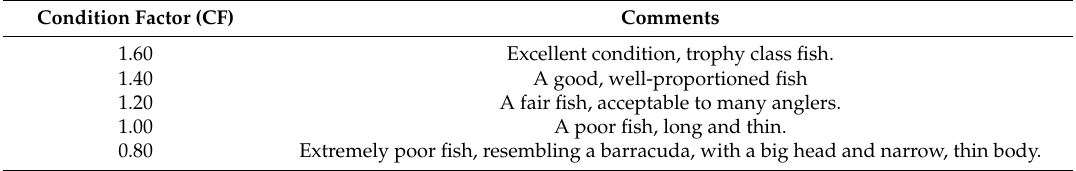
Table 1. Standards of condition factor (CF) used in trout and salmonid fish (Barnham and Baxter, [15]). Condition Factor